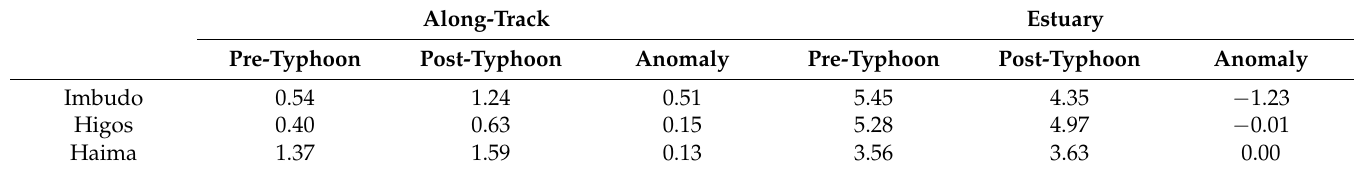
Table 4. The area-average of C chla and C chla anomalies before and after the selected typhoons. Along-Track Estuary Pre-Typhoon Post-Typhoon Anomaly Pre-Typhoon Post-Typhoon Anomaly Imbudo 0.54 1.24